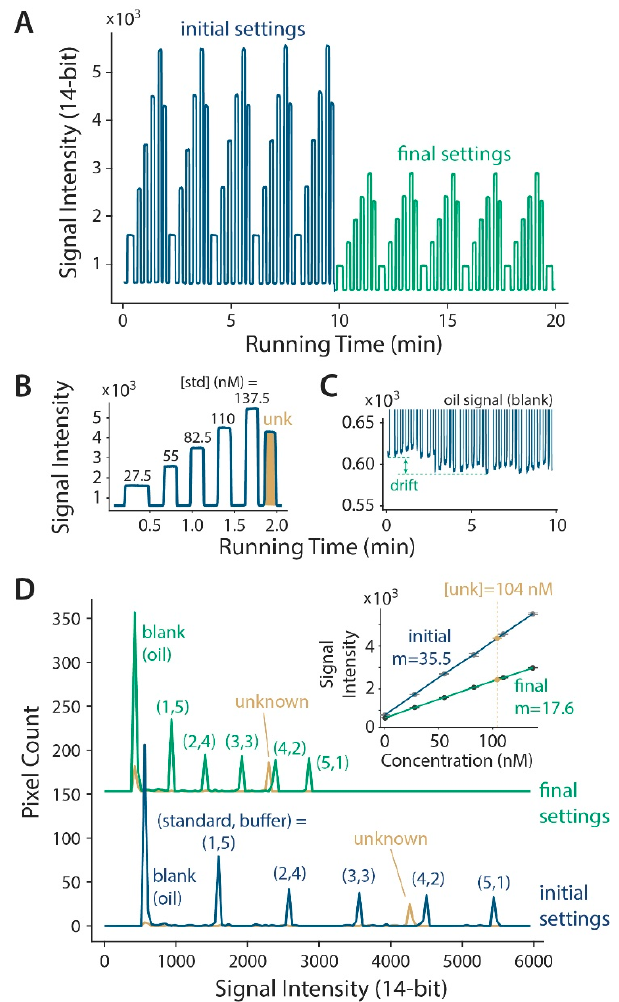
Figure 2. Continuous calibration with automated droplet formation and merging. ( A ) Raw fluorescence emission data shows that the droplet contents were programmable. Data is shown under initial settings at a higher excitation light intensity (blue) and with final settings after decreasing the light (green) in real time. ( B ) A magnified segment of this data, with pulses labeled using final, post-merge concentrations of fluorescein standard. Data from the unknown droplet is shaded in gold. ( C ) Magnified view of the oil signal shows a typical optical system drift that can be corrected using our µ Chopper method [8,12,22]. ( D ) Histogram analysis reveals the method’s capability for a highly precise control of the droplet contents. The peaks are labeled with the pre-merge, programmed numbers of standard and buffer droplets. The inset shows the linear calibrations under the initial and final settings. As shown in Figure 2D, the programmable droplet formation and merging enables a high-precision control over the final droplet